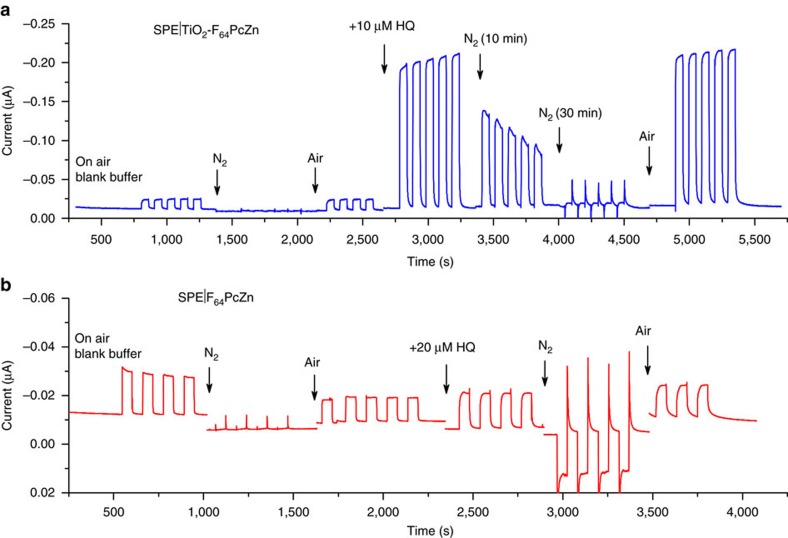
The effect of O2 on the photocurrent.The amperometric response was recorded for SPE|TiO2-F64PcZn (a) and directly adsorbed F64PcZn, SPE|F64PcZn (b). The measurements were performed under 655 nm red laser illumination, in the blank buffer (0.1 M KCl, 0.02 M KH2PO4, pH=7) and in the presence of 10 μM HQ. Amperometry voltage: −0.1 V.